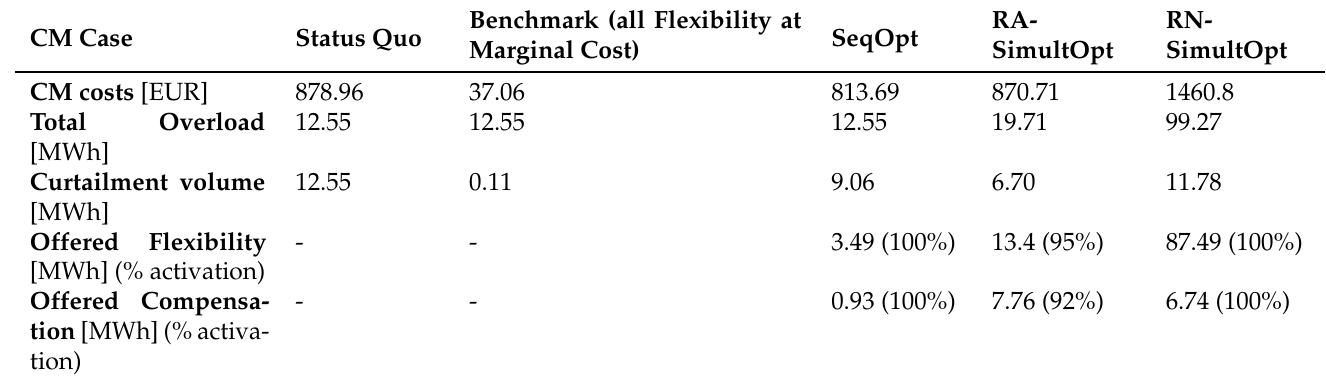
Table 1. Quantitative results of case